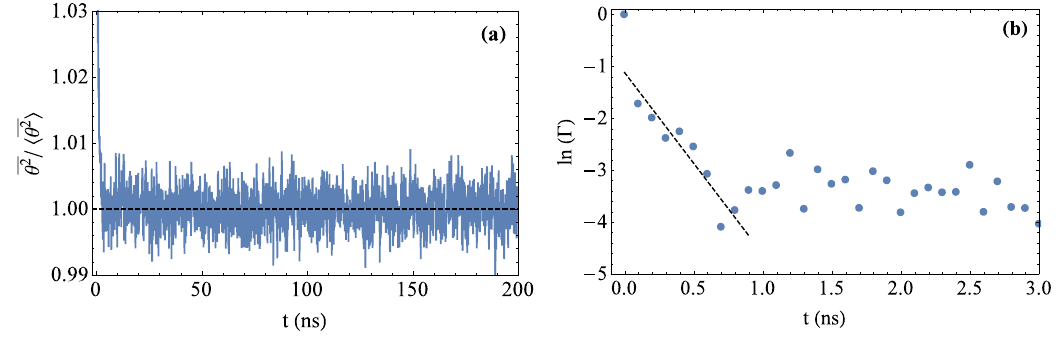
Figure 4. ( a ) The mean-square bond deflection angle, θ 2 , quickly reaches equilibrium. The dashed black line is the ensemble average, (cid:104) θ 2 (cid:105) = 0.73 radians. ( b ) The correlation function for a selected simulation exponentially decays to near zero within 1 ns of simulation time.